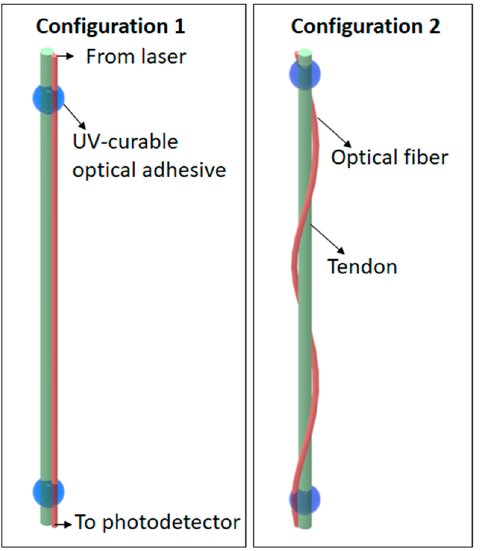
Figure 2. Configurations employed on the material characterization and sensor’s analysis.